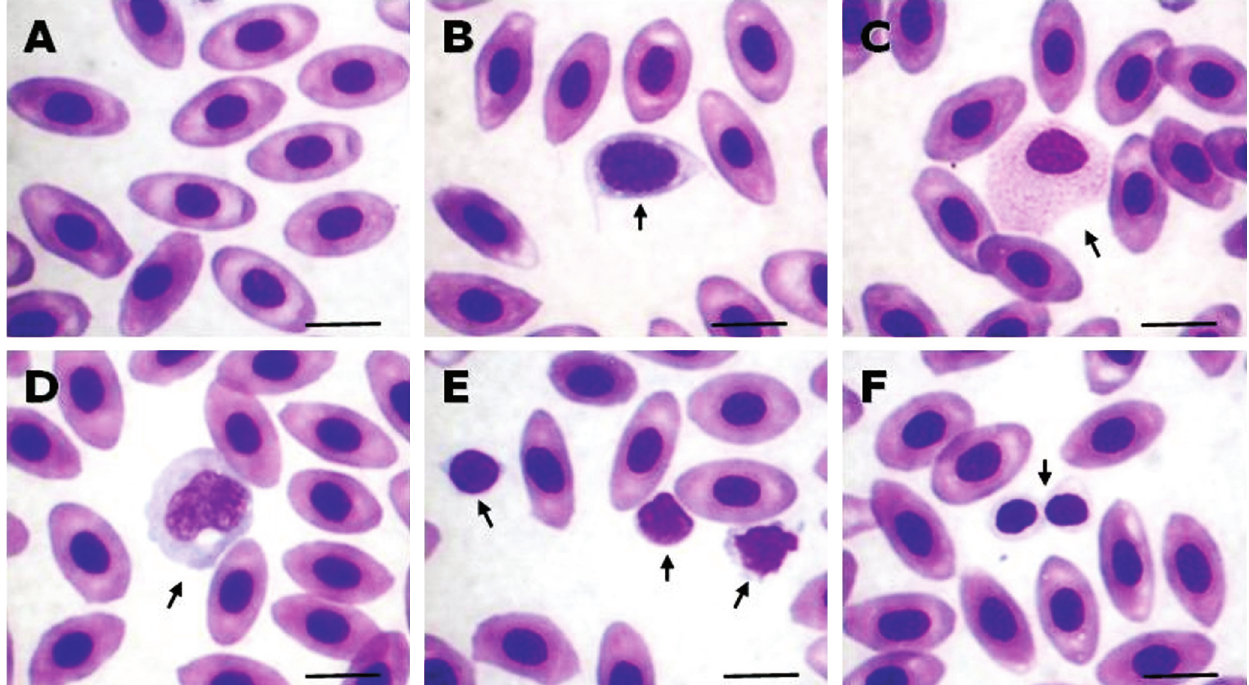
Fig. 5. Blood cells in tucunaré C . temensis stained by MGGW. A - Erythrocytes, B - Polychromatic erythroblasts, C - Neutrophil, D - Monocyte, E - Lymphocyte, and F - Thrombocytes. Scale bars = 5 μ m.